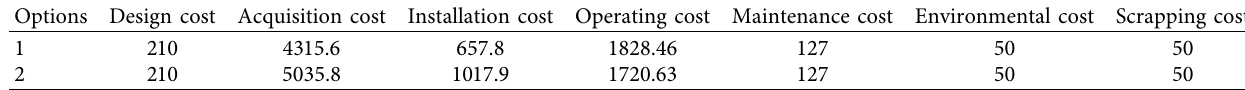
Table 6: Cost components (million RMB).